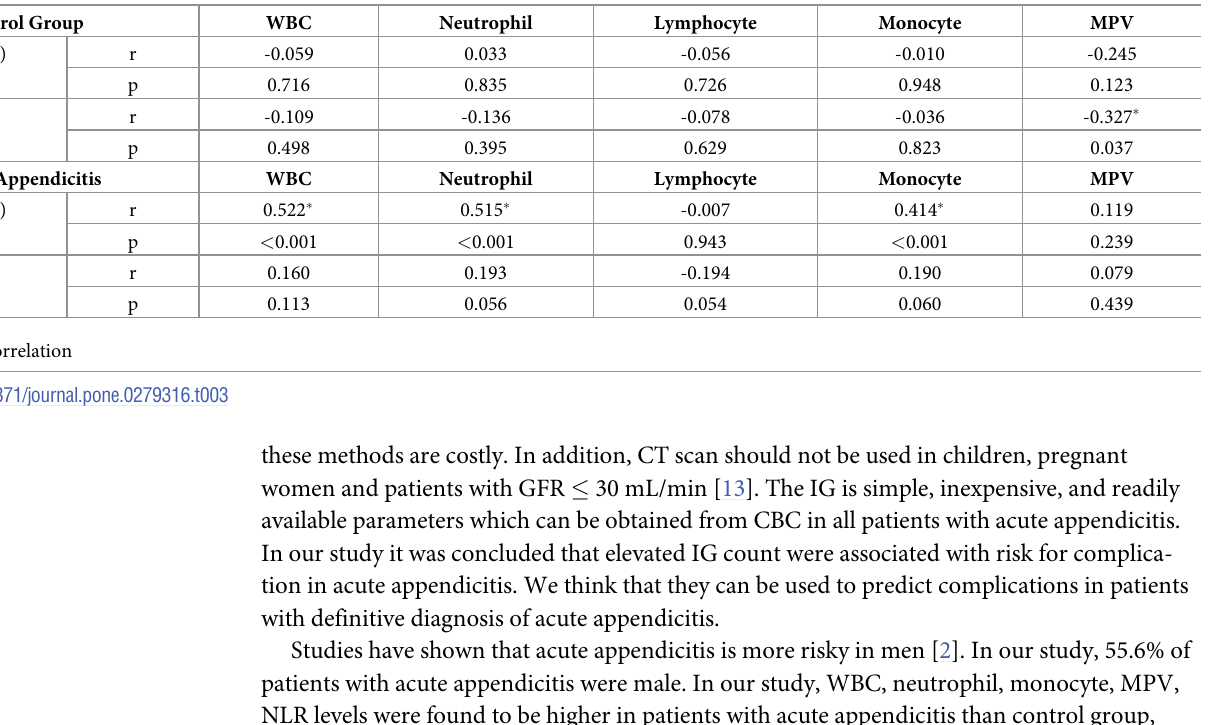
Table 3. Correlation analysis in control and acute appendicitis groups.